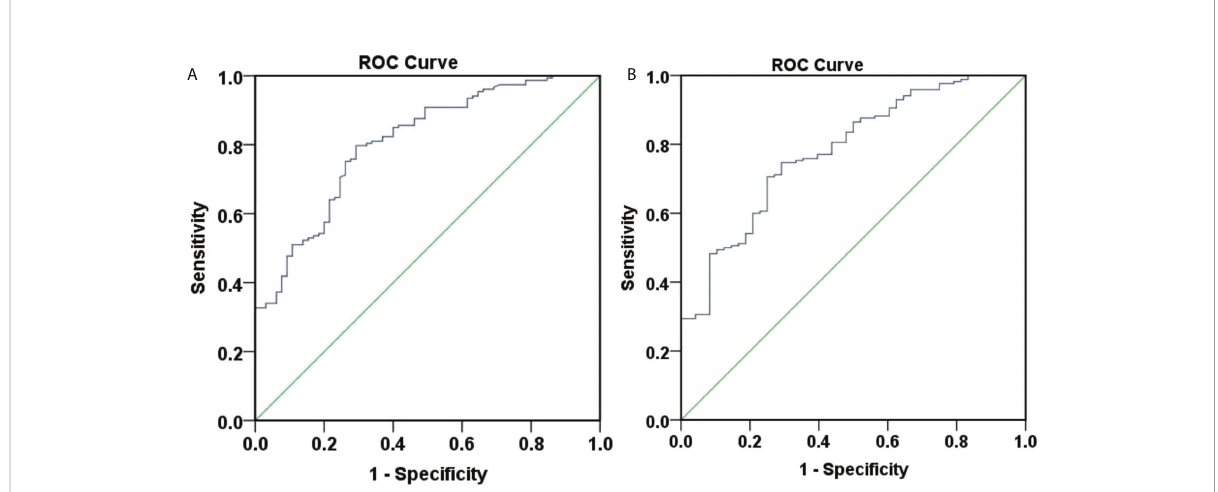
FIGURE 5 ROC curve of 48-weeksHBsAg clearance and seroconversion predicted by baseline HBsAg. (A) ROC curve of 48-weeks HBsAg clearance predicted by baseline HBsAg, the area under the curve was 0.807, 95% CI (0.746, 0.868), with good accuracy. The optimal cut-off value for HBsAg was 152.0 IU/ml, the Youden index was 0.505, the sensitivity was 0.797, and the speci fi city was 0.708. When the sensitivity was 95%, the HBsAg was 30.5 IU/ml, and when the speci fi city was 95%, the HBsAg was 679.0 IU/ml. (B) ROC curve of 48-weeks HBsAg seroconversion predicted by baseline HBsAg, the area under the curve was 0.782, 95% CI (0.711, 0.852), with average accuracy. The optimal cut-off value for HBsAg was 181.9 IU/ml, the Youden index was 0.456, the sensitivity was 0.706, and the speci fi city was 0.750. When the sensitivity was 95%, the HBsAg was 20.41 IU/ml, and when the speci fi city was 95%, the HBsAg was 711.85